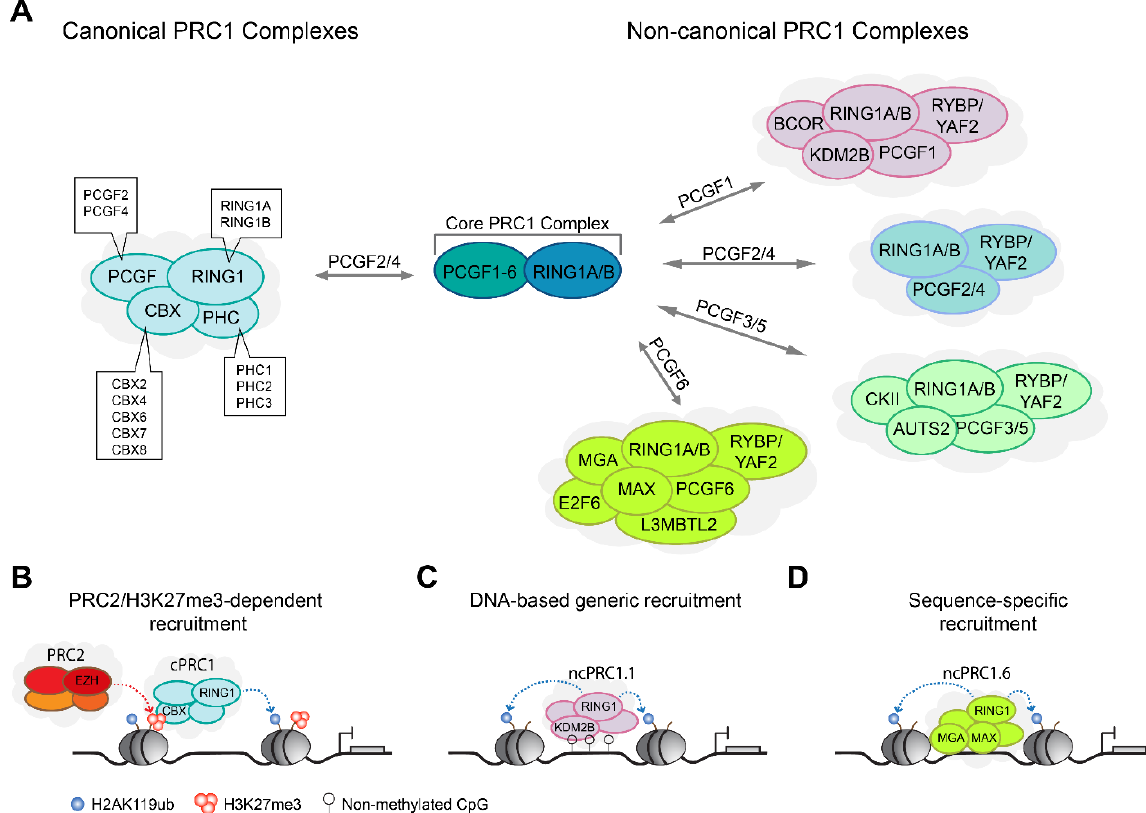
Figure 1. Composition of PRC1-type complexes. ( A ) PRC1 complexes are divided into two main groups, canonical PRC1 (cPRC1) complexes and non-canonical (ncPRC1) complexes. Both groups contain, at their core, a PCGF subunit, together with an E3 ubiquitin ligase subunit RING1A or RING1B that catalyzes H2AK119ub. cPRC1 complexes are restricted to PCGF2 or PCGF4 and are defined by the presence of PHC protein and CBX protein that can recognize PRC2-mediated H3K27me3. ncPRC1 complexes lack CBX and PHC proteins and instead contain RYBP/YAF2 proteins, and their cores can be formed with any of the PCGF1-6 proteins. ( B – D ) Illustration of three major mechanisms for PRC1 recruitment. ( B ) A PRC2-dependent mechanism in which cPRC1 complexes are recruited to chromatin via H3K27me3 reader activity of CBX proteins. ( C ) A DNA-based generic recruitment of ncPRC1 complexes via KDM2B binding activity to genomic regions enriched for CpG islands. ( D ) A sequence-specific recruitment of ncPRC1 complexes via interaction with transcription factors.